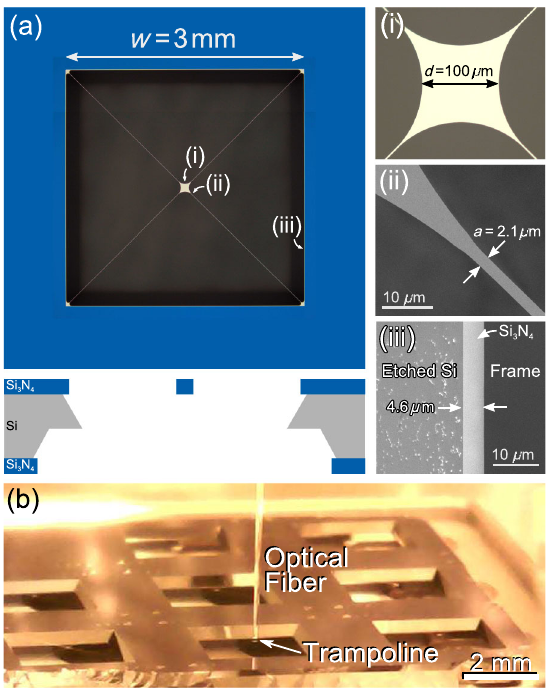
FIG. 1. Fabricated Si 3 N 4 trampoline resonators. (a) Optical image of the released structure with a window size of w ¼ 3 mm (upper) and a schematic of its KOH-etched cross section (lower). Right-hand images show (i) an optical image of the d ¼ 100 - μ m- wide central pad, (ii) a scanning electron microscope (SEM) image of the a ¼ 2 . 1 - μ m-wide tether (near the pad), and (iii) an SEM image of the 4 . 6 - μ m-wide overhanging nitride. Left from the overhang is the angled, KOH-etched silicon substrate show- ing typical roughness and residues. (b) Optical image of devices inside the ultrahigh vacuum (UHV) fiber